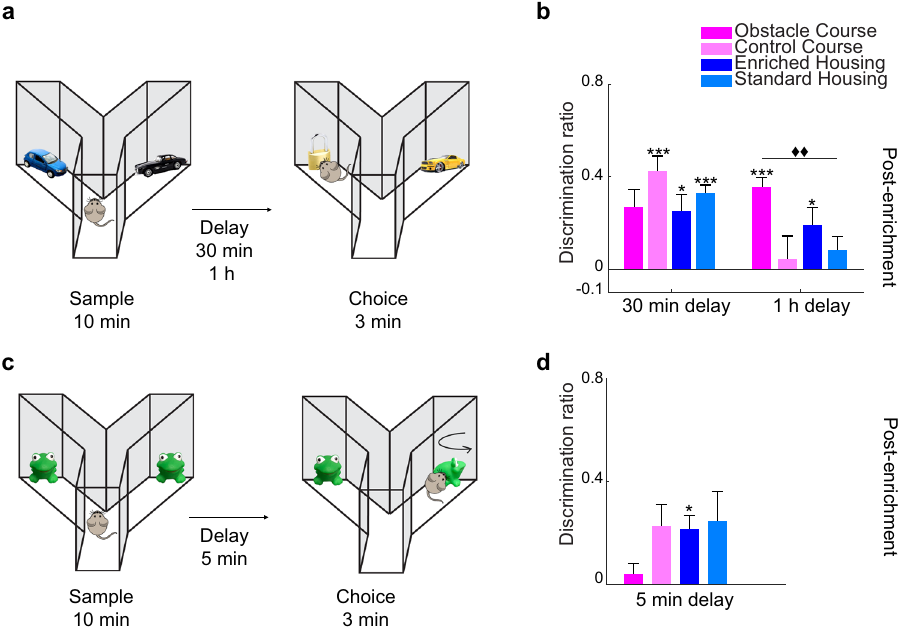
Fig. 5 OCR and VIOR — Enhancement of both object category recognition (OCR) and object recognition despite rotational changes to objects (VIOR) with OC training. a Schematic representation of the object category recognition (OCR) experiment. b OCR task performance with two delay durations. With a 30-min delay, the CC, EH, and SH groups signi fi cantly discriminated above chance, demonstrating intact object category memory. With an increased delay to 1 h, the OC group demonstrated enhanced object category memory, performing signi fi cantly higher compared to the SH group (Delay x group interaction p = 0.001, delay main effect p = 0.001, and group main effect p = 0.532). The OC and EH groups signi fi cantly discriminated the novel category above chance. OCR experiments were implemented 1.5 – 2.5 months post-discontinuation of enrichment. c Schematic representation of the view-invariant object recognition (VIOR) experiment. d VIOR task performance. The OC group treated the rotated object as familiar, equally exploring rotated, and unrotated objects in the choice phase. The EH group signi fi cantly discriminated the rotated object. No signi fi cant group effect was observed ( p = 0.240). VIOR experiments were implemented 3 months post-discontinuation of enrichment. * p < 0.05, ** p < 0.01, *** p < 0.001 indicate signi fi cant two-tailed paired- sample t -tests (choice DR vs. sample DR). ♦♦ p < 0.01, ♦♦♦ p < 0.001 indicate a signi fi cant difference between groups (two-tailed independent samples t -test, Bonferroni correction p = 0.0083). Error bars represent s.e.m. across animals.